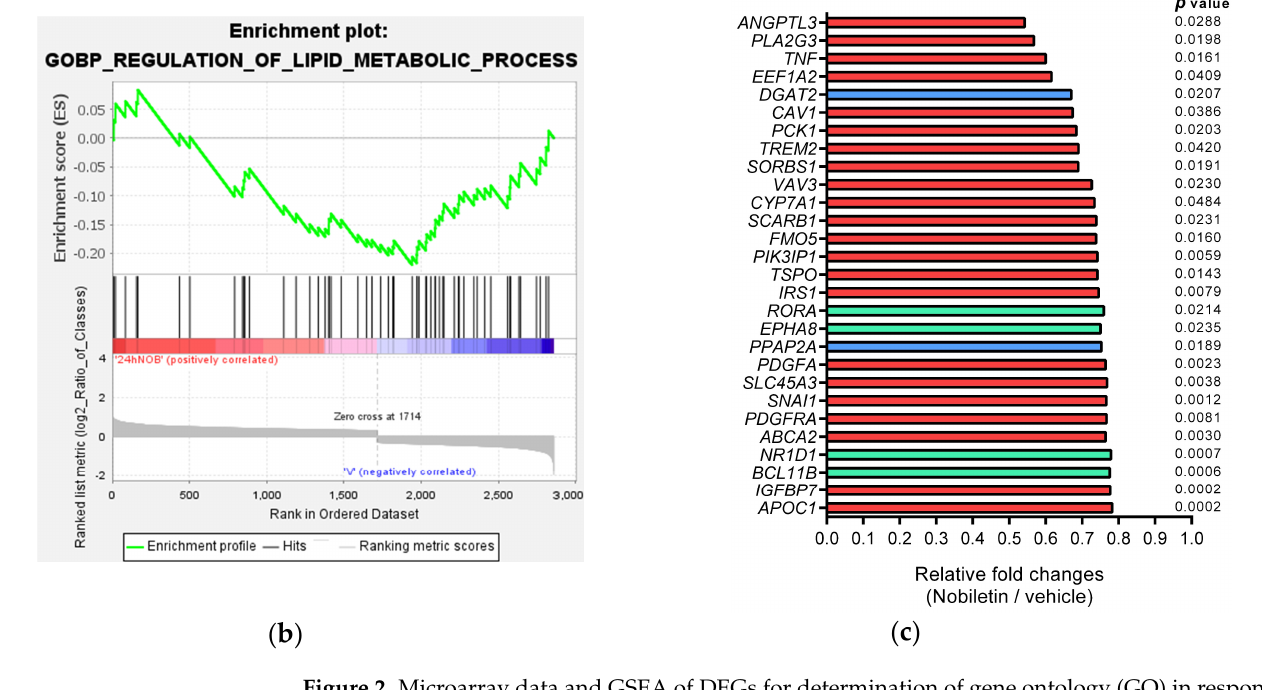
Figure 2. Microarray data and GSEA of DEGs for determination of gene ontology (GO) in response to nobiletin treatment in hepatic cells. HepG2 cells were treated with vehicle or nobiletin (40 µ M) for 24 h, and the differential mRNA expression profiles were analyzed using a human cDNA microarray. ( a ) Flowchart of the transcriptome analysis and identification of DEGs in nobiletin-treated HepG2 cells. ( b ) GSEA demonstrating that the GO BP signature “Enrichment plot: GOBP Regulation of Lipid Metabolic Process” (GO: 0019216) gene set is enriched and downregulated with the DEGs in nobiletin-treated cells. The barcode shows the position of the genes involved in the gene set. ( c ) The fold changes of 28 significantly downregulated expression genes associated with GO:0019216 in response to nobiletin treatment ( p < 0.05). Table 1. The twenty-eight core enrichment genes associated with GO BP regulation of lipid metabolic process (GO:0019216) were downregulated by nobiletin treatment.